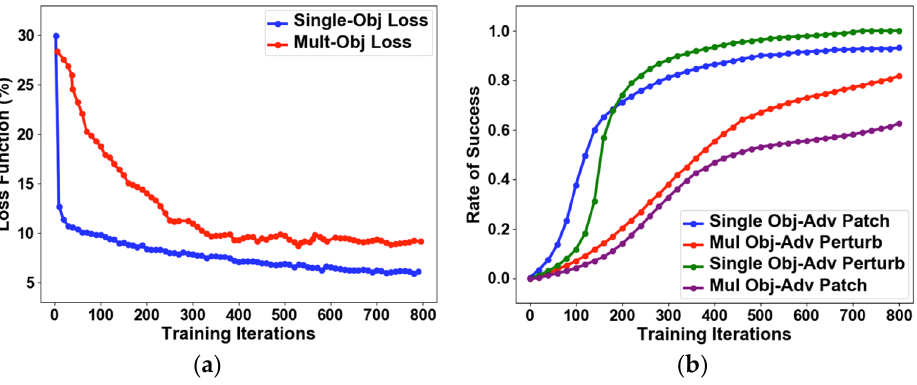
Figure 10. Performance based on training iterations. ( a ) Loss comparison curve of a single object and multi-object adversarial examples. ( b ) Comparison curve of the success rate of a single object and multi-object adversarial examples.